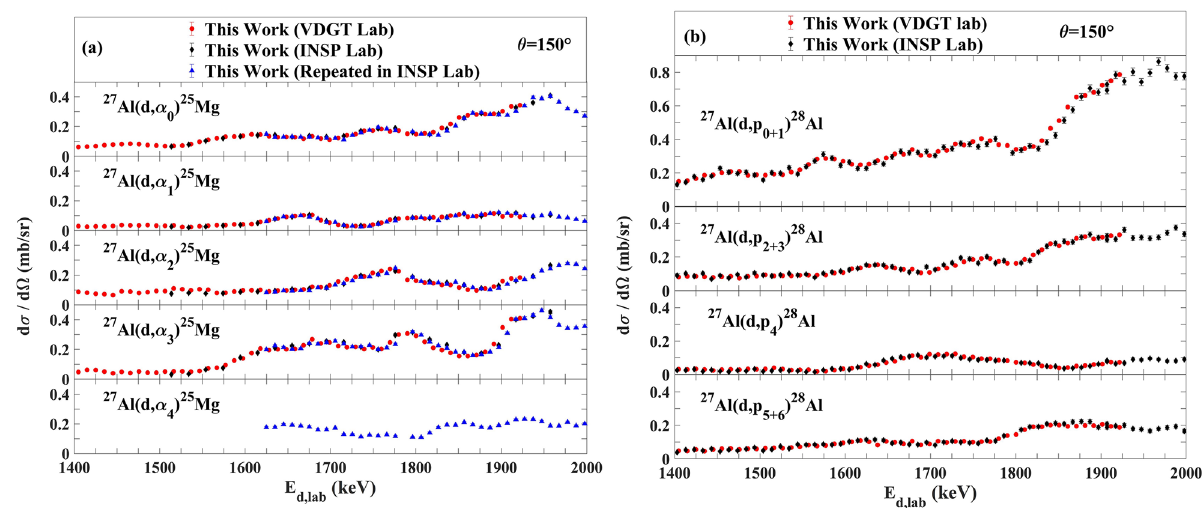
Figure 10. The comparison between our data from VDGT and from INSP at 150° for the ( a ) 27 Al(d,α 25 Mg and ( b ) 27 Al(d,p 28 Al 0,1,2,3,4 ) 0+1,2+3,4,5+6 )